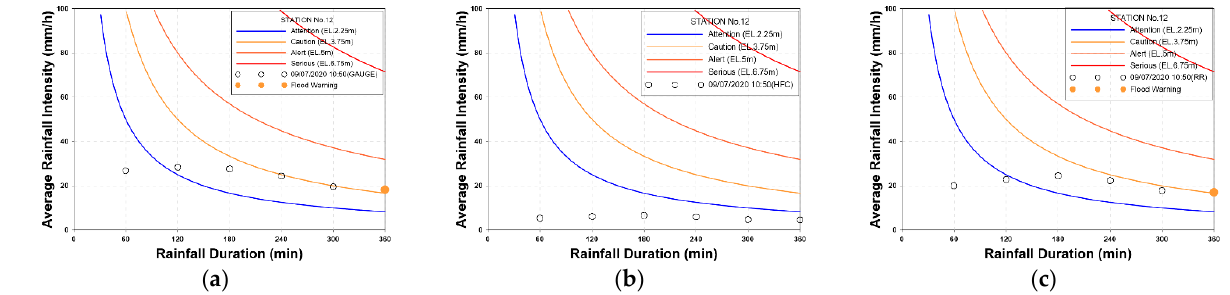
Figure 12. Calculation results of the flood forecast information for 7 September 2020, at 10:30.